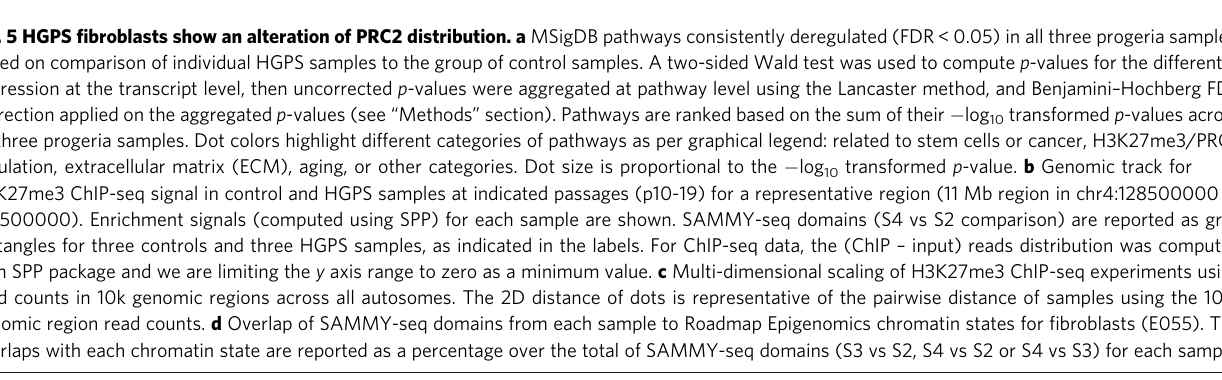
Fig. 5 HGPS fi broblasts show an alteration of PRC2 distribution. a MSigDB pathways consistently deregulated (FDR < 0.05) in all three progeria samples, based on comparison of individual HGPS samples to the group of control samples. A two-sided Wald test was used to compute p -values for the differential expression at the transcript level, then uncorrected p -values were aggregated at pathway level using the Lancaster method, and Benjamini – Hochberg FDR correction applied on the aggregated p -values (see “ Methods ” section). Pathways are ranked based on the sum of their − log 10 transformed p -values across all three progeria samples. Dot colors highlight different categories of pathways as per graphical legend: related to stem cells or cancer, H3K27me3/PRC2 regulation, extracellular matrix (ECM), aging, or other categories. Dot size is proportional to the − log 10 transformed p -value. b Genomic track for H3K27me3 ChIP-seq signal in control and HGPS samples at indicated passages (p10-19) for a representative region (11 Mb region in chr4:128500000 to 139500000). Enrichment signals (computed using SPP) for each sample are shown. SAMMY-seq domains (S4 vs S2 comparison) are reported as gray rectangles for three controls and three HGPS samples, as indicated in the labels. For ChIP-seq data, the (ChIP – input) reads distribution was computed with SPP package and we are limiting the y axis range to zero as a minimum value. c Multi-dimensional scaling of H3K27me3 ChIP-seq experiments using read counts in 10k genomic regions across all autosomes. The 2D distance of dots is representative of the pairwise distance of samples using the 10k genomic region read counts. d Overlap of SAMMY-seq domains from each sample to Roadmap Epigenomics chromatin states for fi broblasts (E055). The overlaps with each chromatin state are reported as a percentage over the total of SAMMY-seq domains (S3 vs S2, S4 vs S2 or S4 vs S3) for